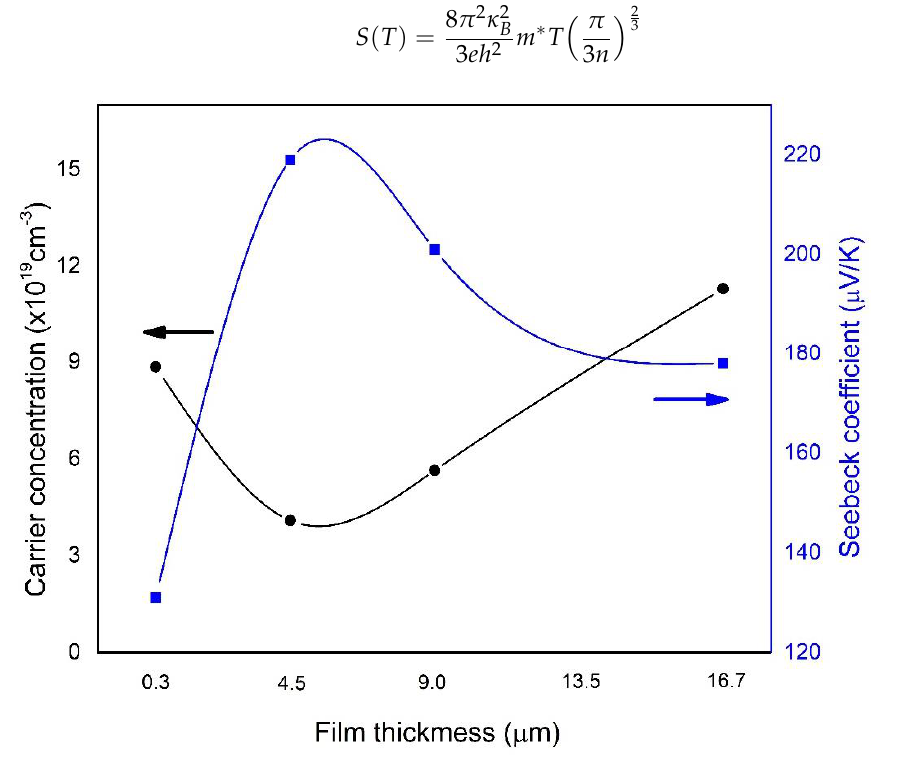
Figure 6. Carrier concentration and Seebeck coefficient of deposited Sb 2 Te 3 films as a function of film thickness.